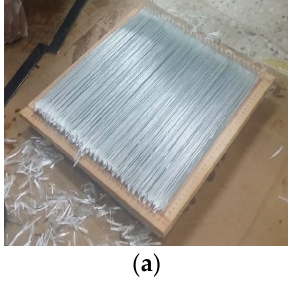
Figure 1. Stages of the manufacturing of the epoxy/fiberglass FGM; ( a ) loom with unidirectional fiberglass bundles, ( b ) pouring epoxy over the fiberglass layers, ( c ) the FGM product, and ( d ) manufactured wear and SPT specimens. Table 1. Mechanical properties of E ‐ glass fiber and epoxy resin. Table 2. The layers’ V f values for the different specimens with average V fa